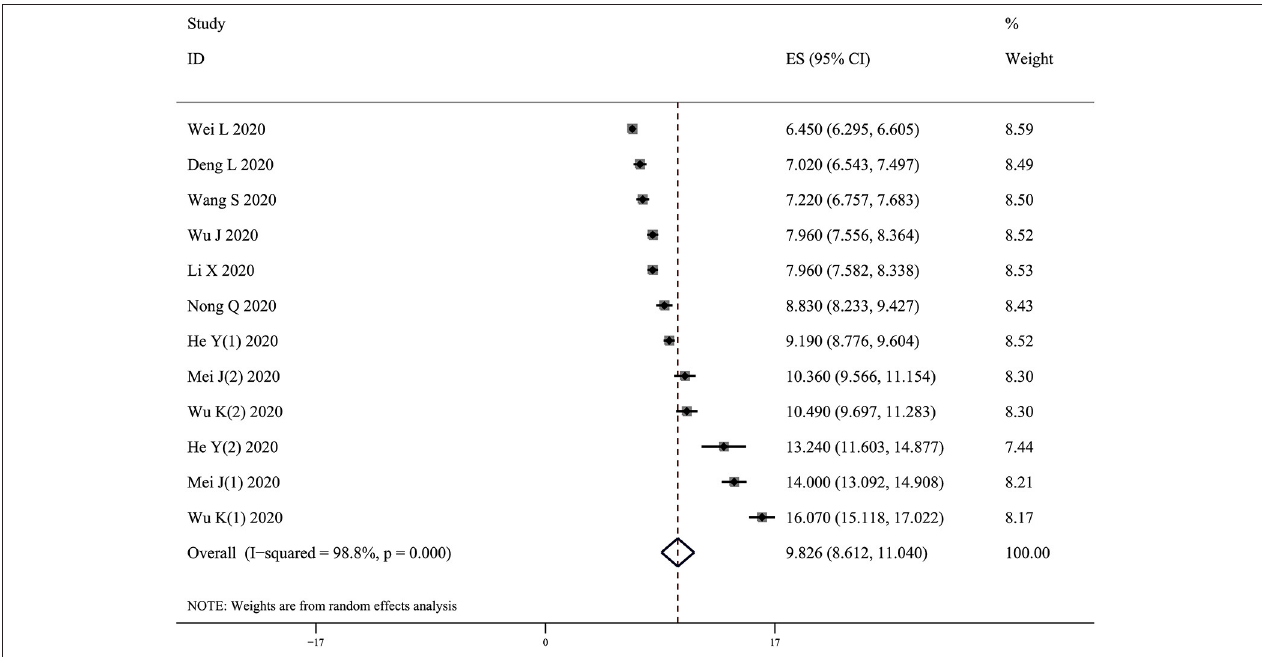
FIGURE 3 | Forest plot of the mean total score of the PSQI.